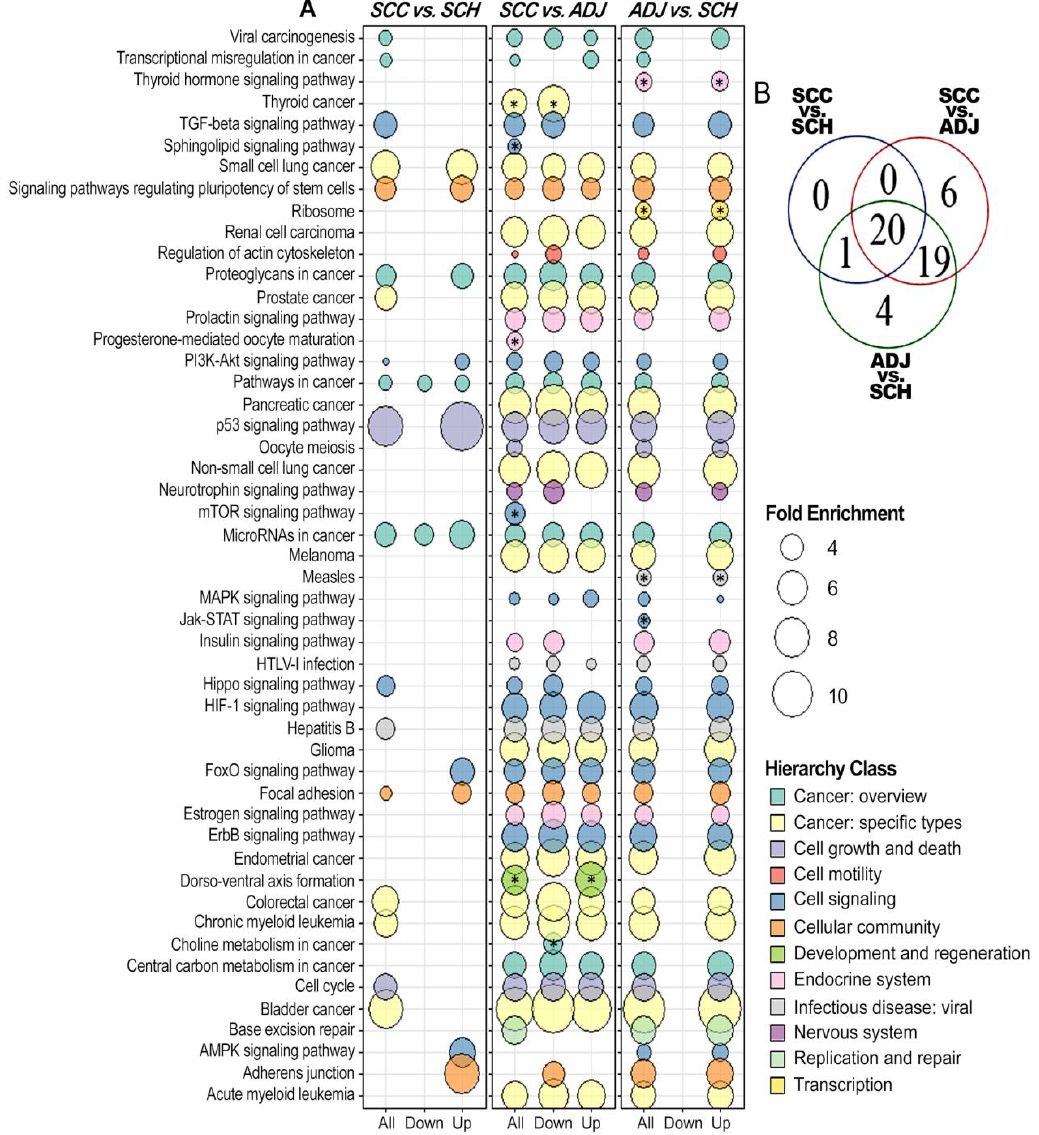
Figure 7. Genome-wide overview of the pathways analysis. Reactome pathways are arranged hierarchically. The center of each of the circular “bursts” is the root of one top-level pathway. Each step away from the center represents the next level above in the pathway hierarchy. The color code denotes the over-representation of that pathway in the input dataset. A numeric ID identifies the biological process significantly over-represented and correlated with a carcinogenic process (01–11), used to discriminate the significant main pathway involved in this process. Light grey represents pathways that are not significantly over-represented.